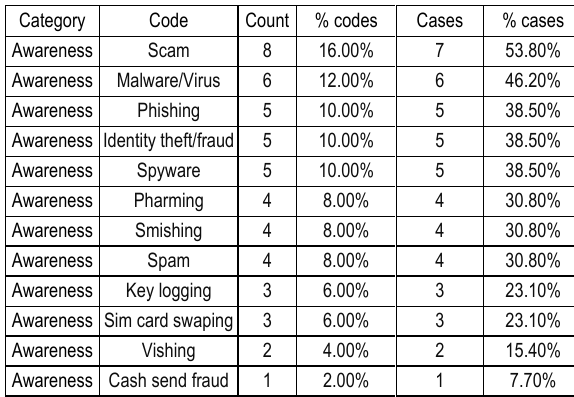
Table 1. Internet banking fraud